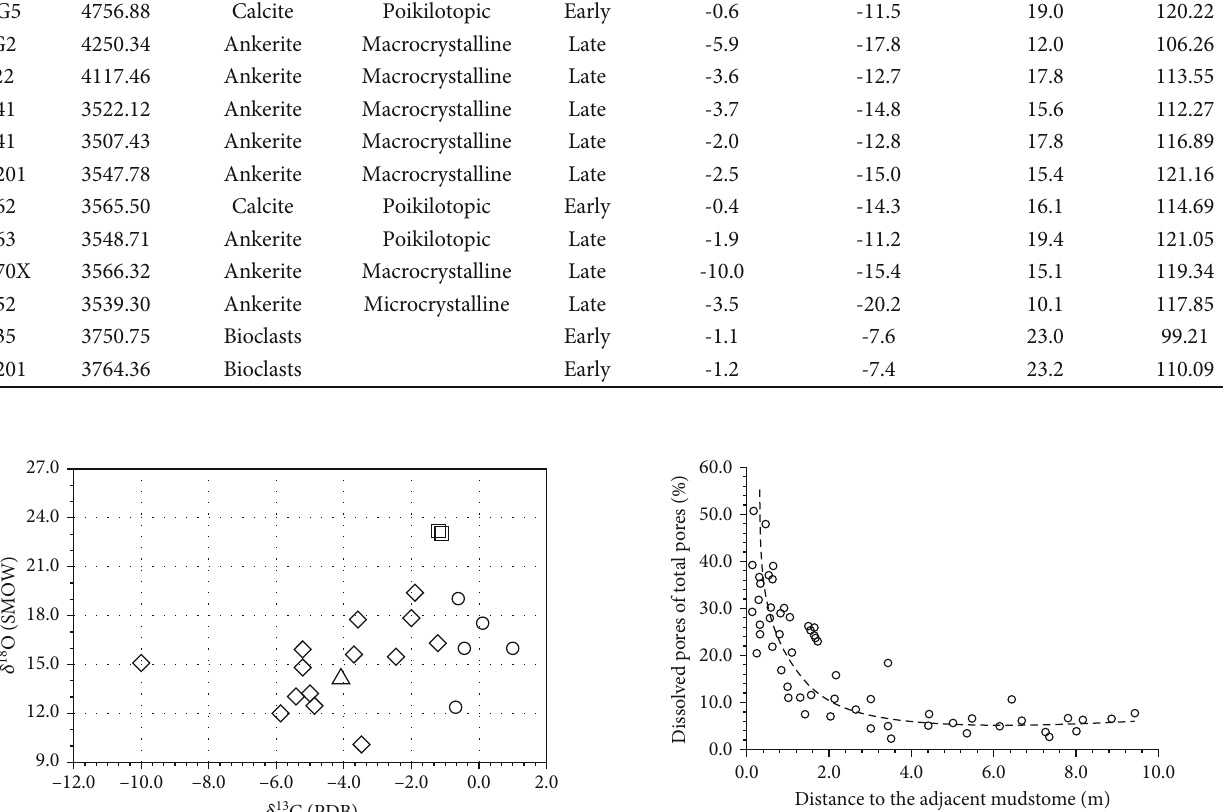
Figure 11: Distribution for the ratio of dissolved pores to total pores in individual sand-body deposited in brained channel with a thickness of 30.6m versus the distance from test point to the contact interface between the sandstone and adjacent